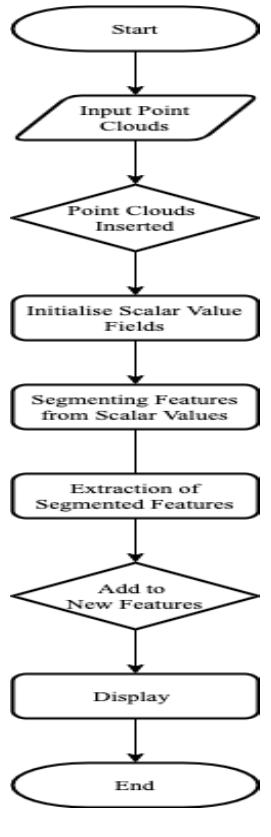
Figure 6: Flowchart of Scalar-Based